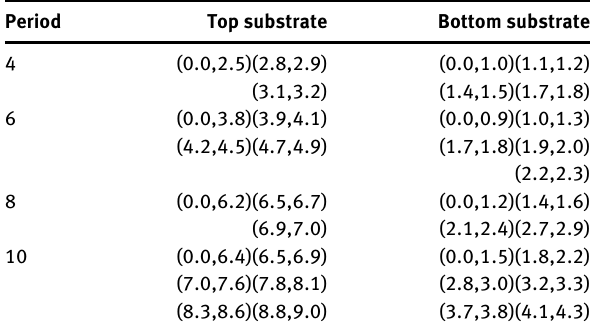
Table 1: Optimal configurations of vertically aligning stripes on both substrates of LC-metasurfaces of different periods. The x -coordinates of stripe edges are given in pairs as (begin, end). All values are expressed in